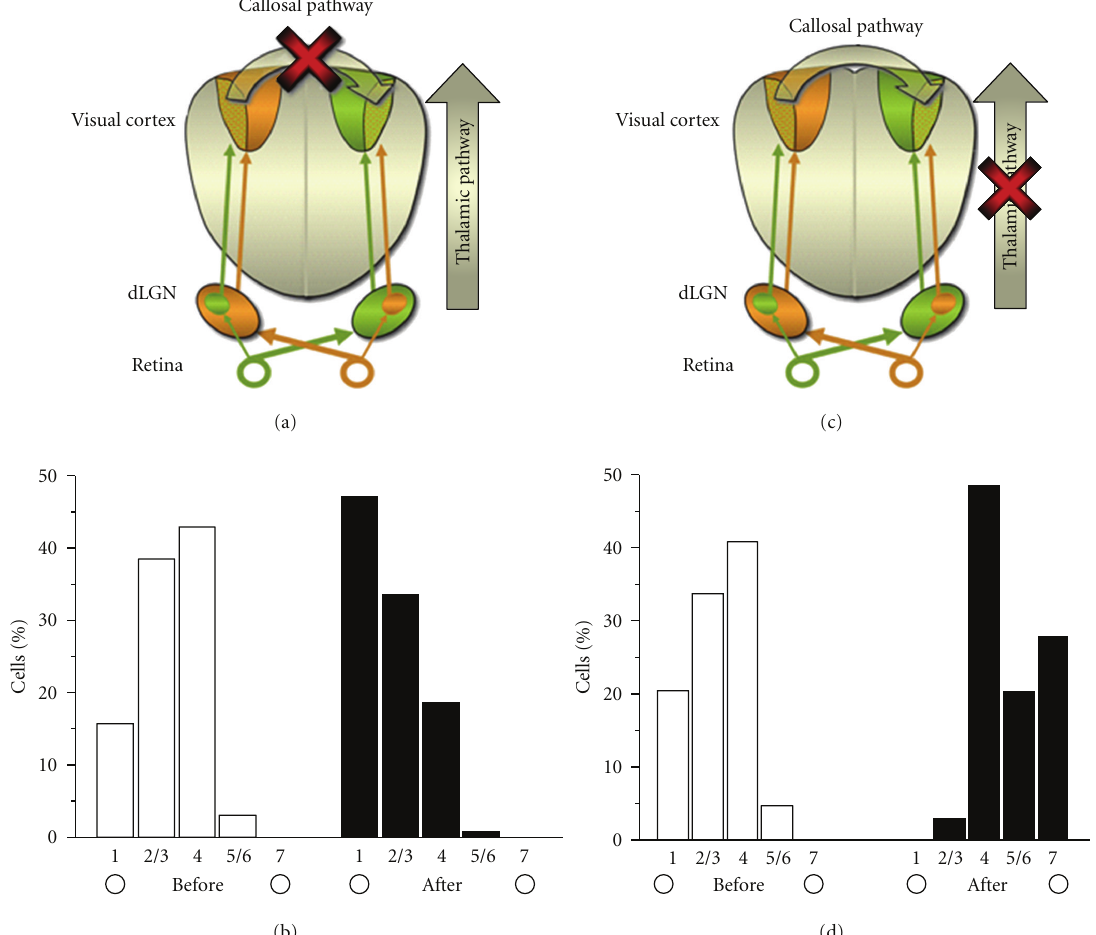
Figure 2: Relative contribution of callosal and thalamic pathways to cortical binocularity. (a, b) E ff ects of acute callosal silencing on OD in rat primary visual cortex. Binocularity was measured in one side before and after acute pharmacological inactivation of the opposite cortex (a). The results indicate a significant shift of cortical OD towards the contralateral eye, due to the reduction of responses driven by the ipsilateral eye (b). (c, d) E ff ects of acute geniculate silencing on OD in rat primary visual cortex. The OD histogram shifts towards the ipsilateral eye following acute geniculate inactivation (d). This e ff ect is mainly due to a loss of contralateral eye-driven input. Data are from [32,